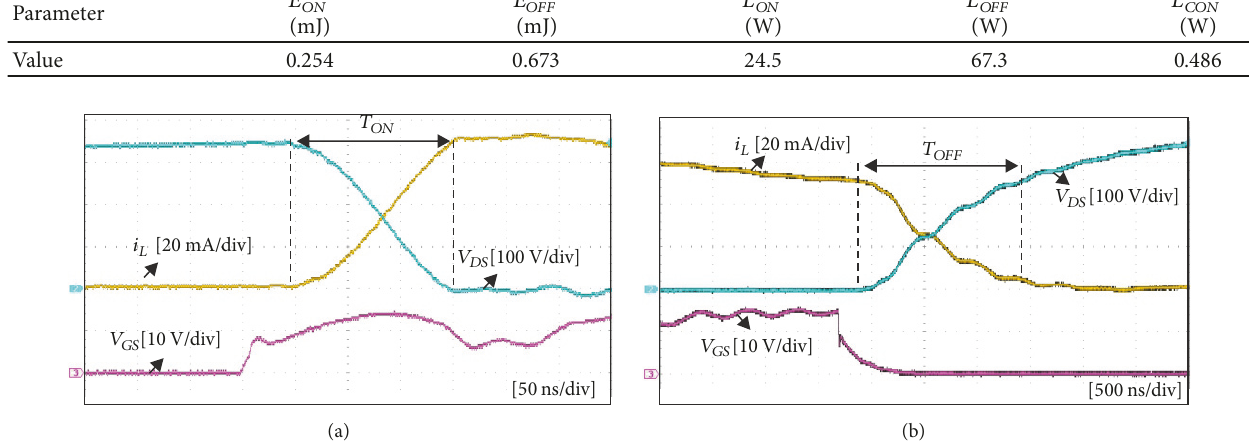
Figure 7: Experimental switching waveforms of the SiC-MOSFET at 𝐹 𝑆𝑊 = 100kHz. (a) ON-state. (b) OFF-state.